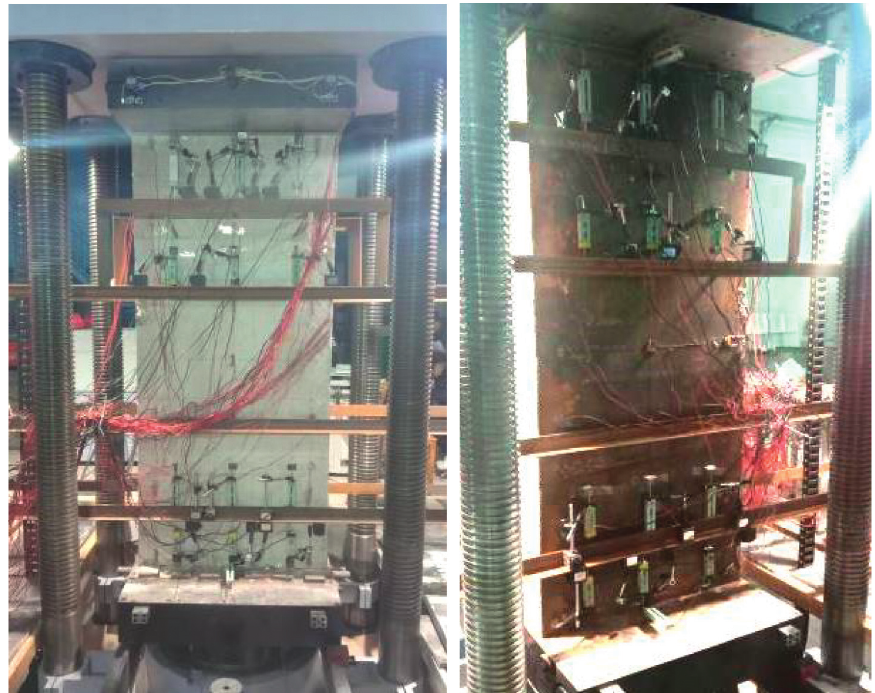
Figure 22: Field displacement meter arrangement for compressive